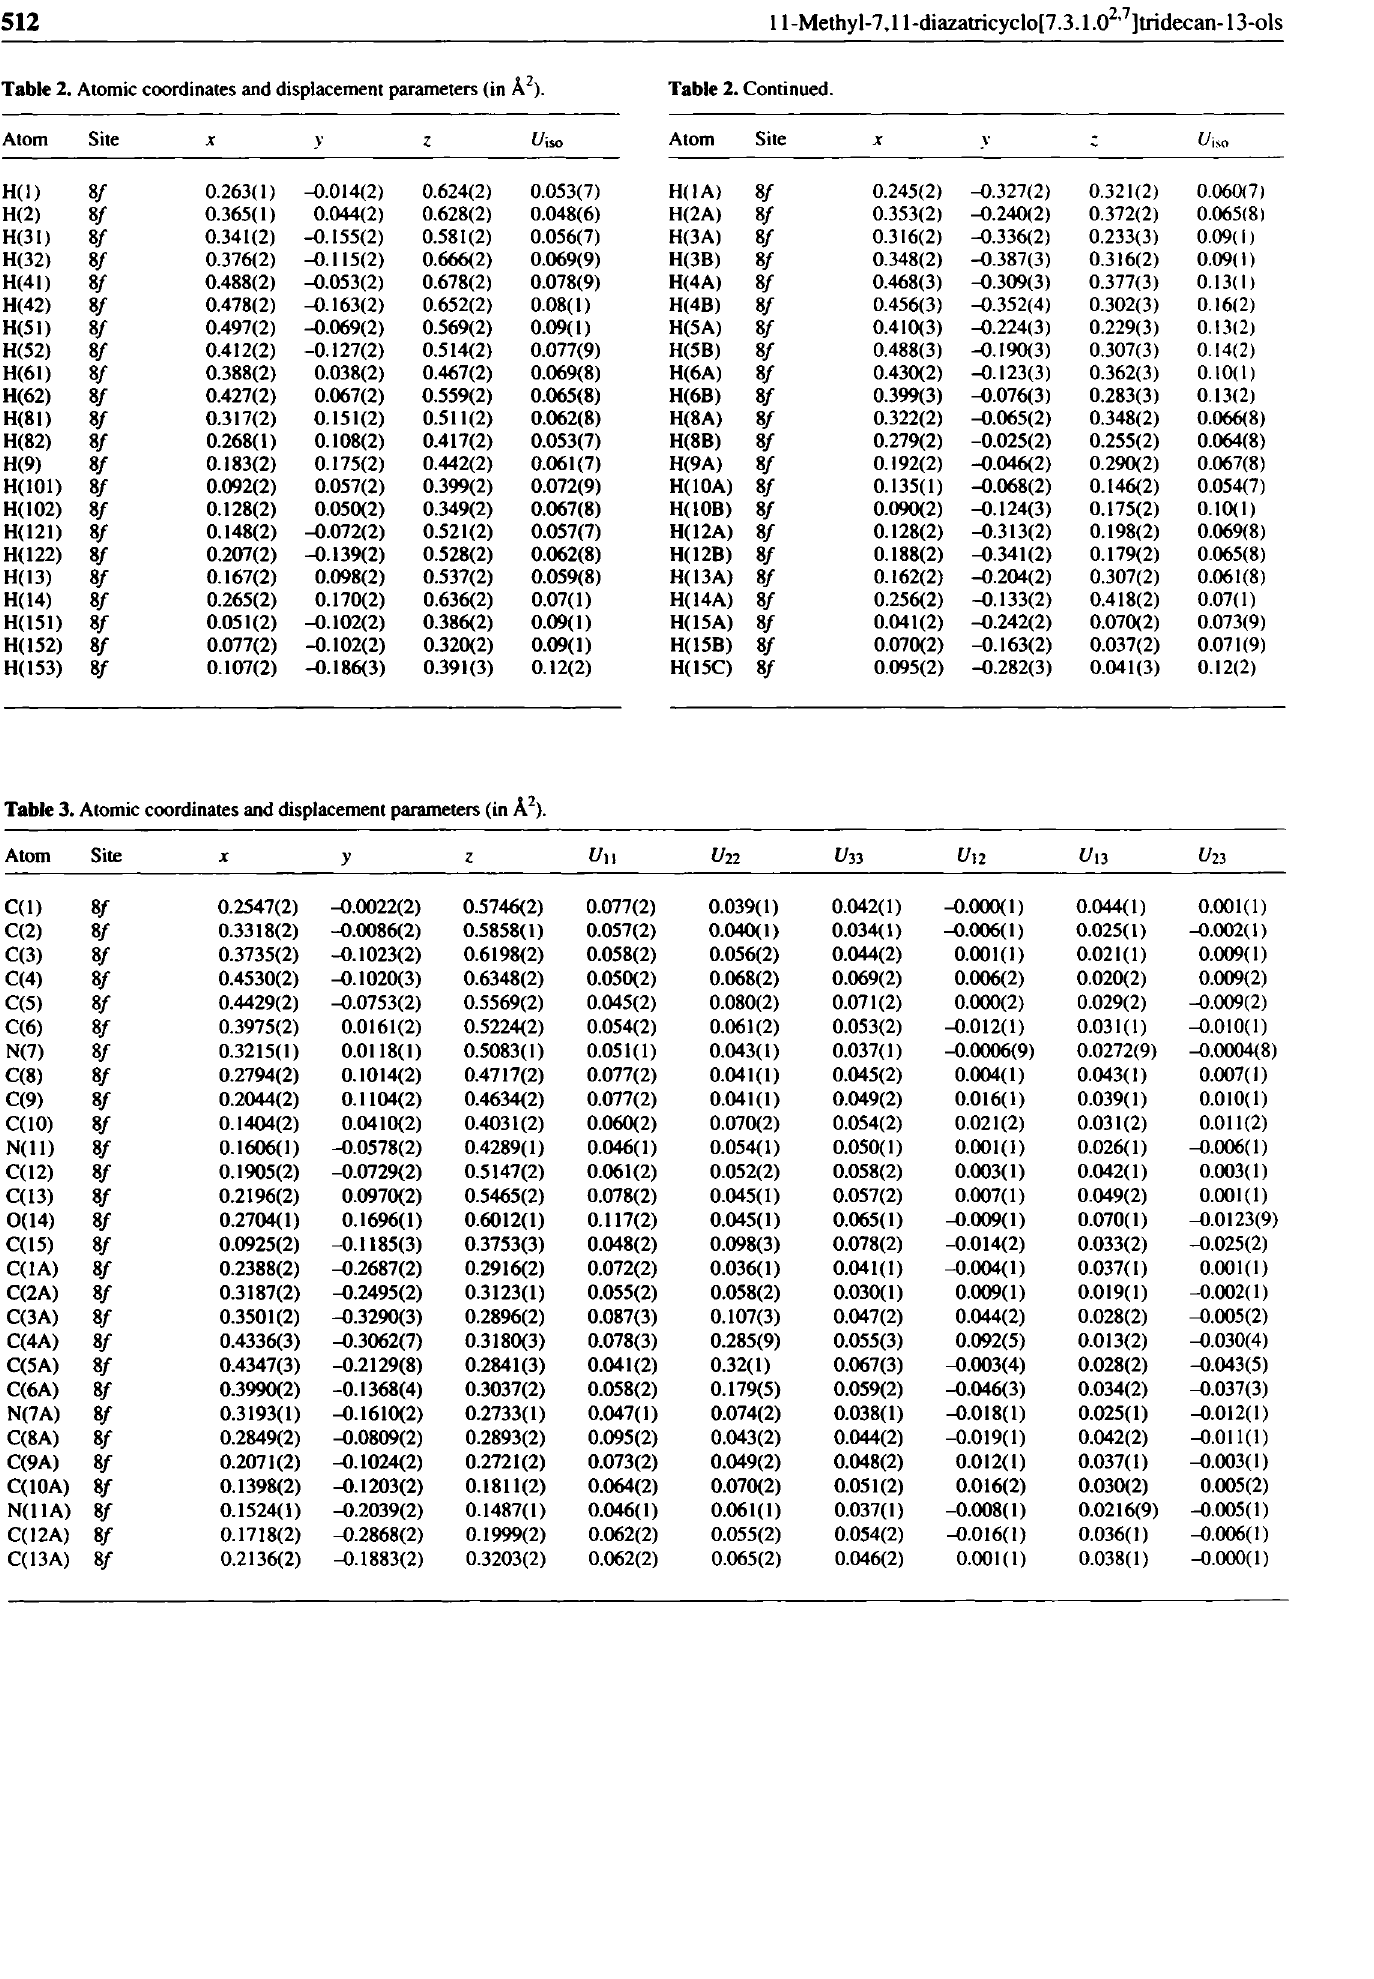
Table 2. Atomic coordinates and displacement parameters (in Ä 2 ).